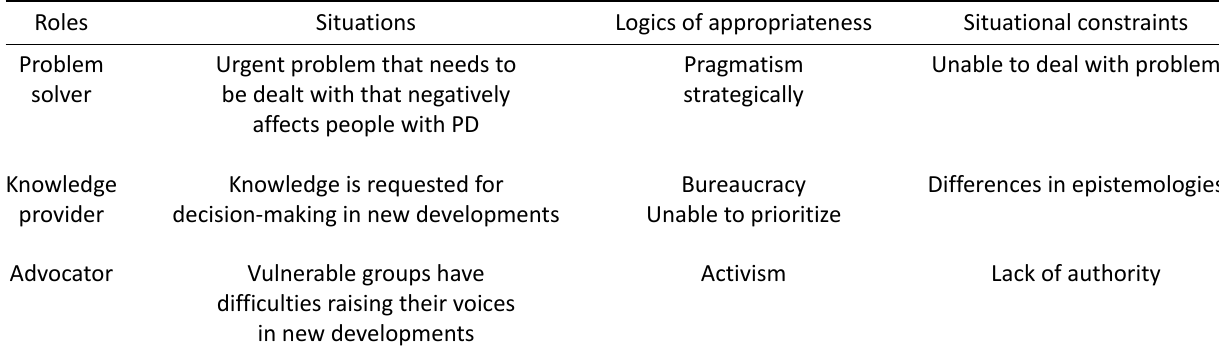
Table 1. Summary of